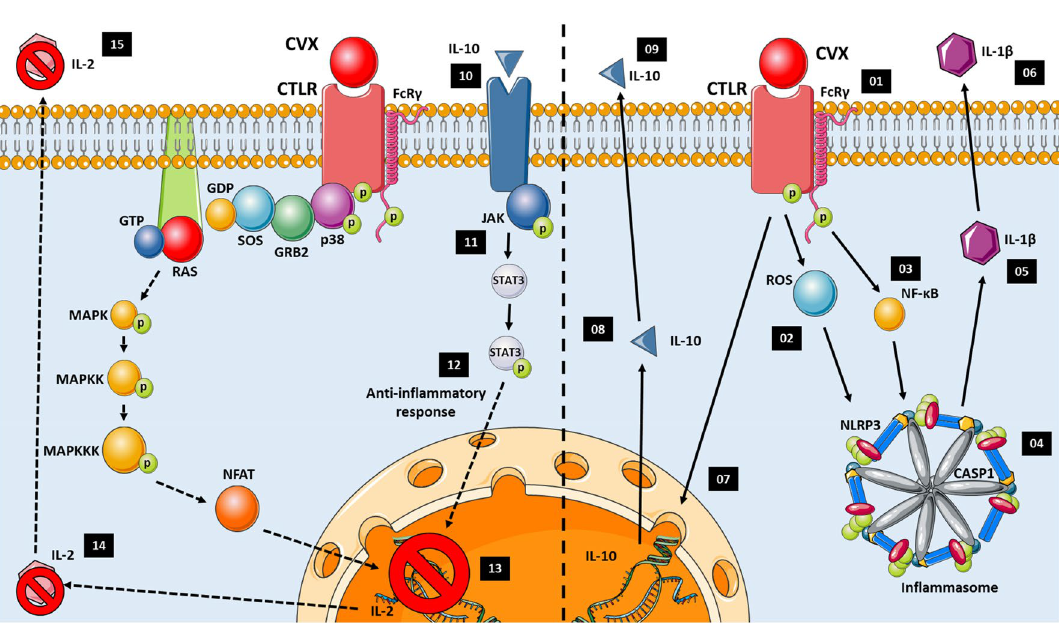
Figure 10. The mechanism of the CVX interaction with the CTLR proposed (Dectin) in the present study. The interaction of CVX with CTLR (1) induces ROS production (2) and NF-κB activation (3). ROS induce the activation of the NLRP3 inflammasome complex (4); stimulating the production (5) and release of the pro-inflammatory cytokine IL-1β (6). The IL-1β production by the interaction of CVX and CTLR, induces the transcription of IL-10 (7); and consequently, its release (8). The interaction of IL-10 with its specific receptor (9), induces JAK-1 phosphorylation (10), initiating signaling via STAT3 (11,12), performing an anti-inflammatory activity, inhibiting transcription (13), production (14) and IL-2 release